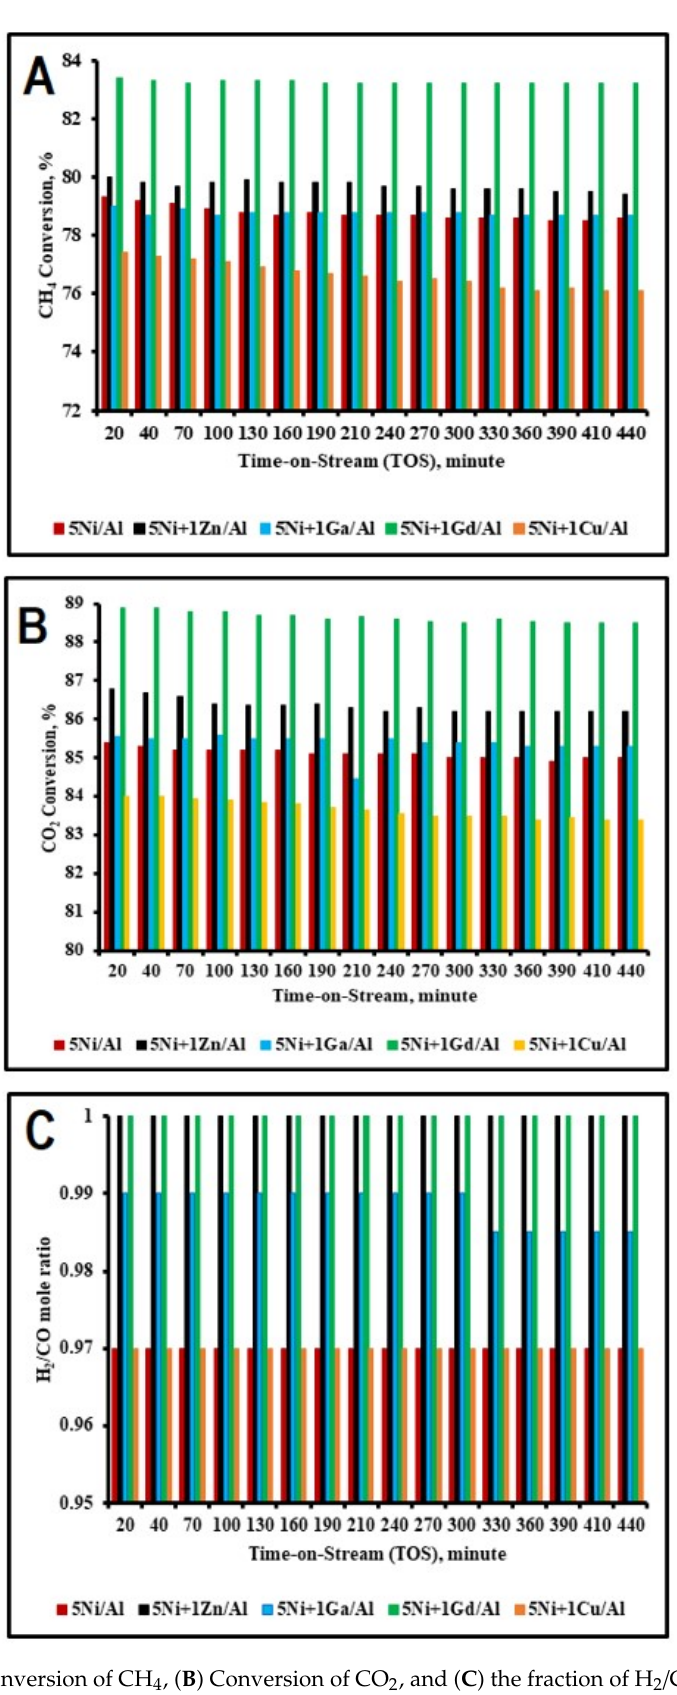
Figure 3. ( A ) Conversion of CH 4 , ( B ) Conversion of CO 2 , and ( C ) the fraction of H 2 / CO at 700 ◦ C, 1.0 Figure 3. (A) Conversion of CH 4 , (B) Conversion of CO 2 , and (C) the fraction of H 2 /CO at 700  C, 1.0 atm and GHSV = 2990 h − atm and GHSV = 2990 h − 1 .